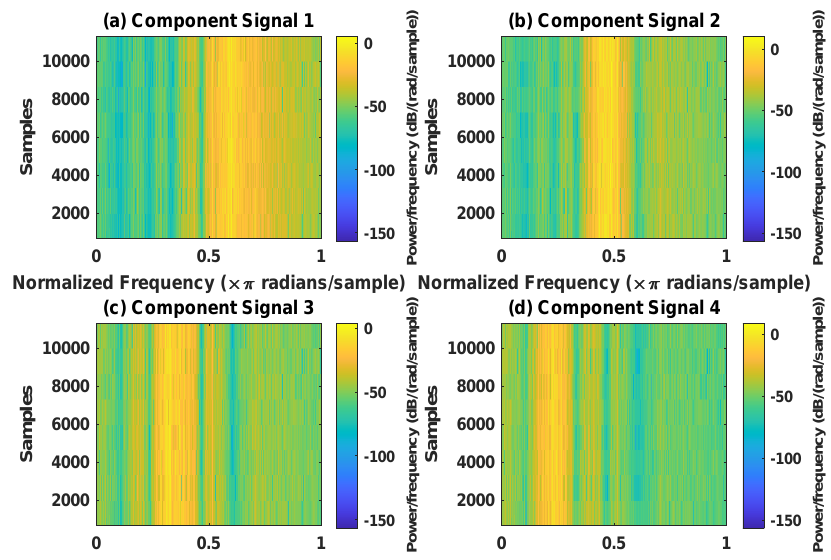
Figure 22. Decomposition results of VMD with m = 16: ( a – d ) time–frequency diagram of 1st to 4th subcomponents, respectively.